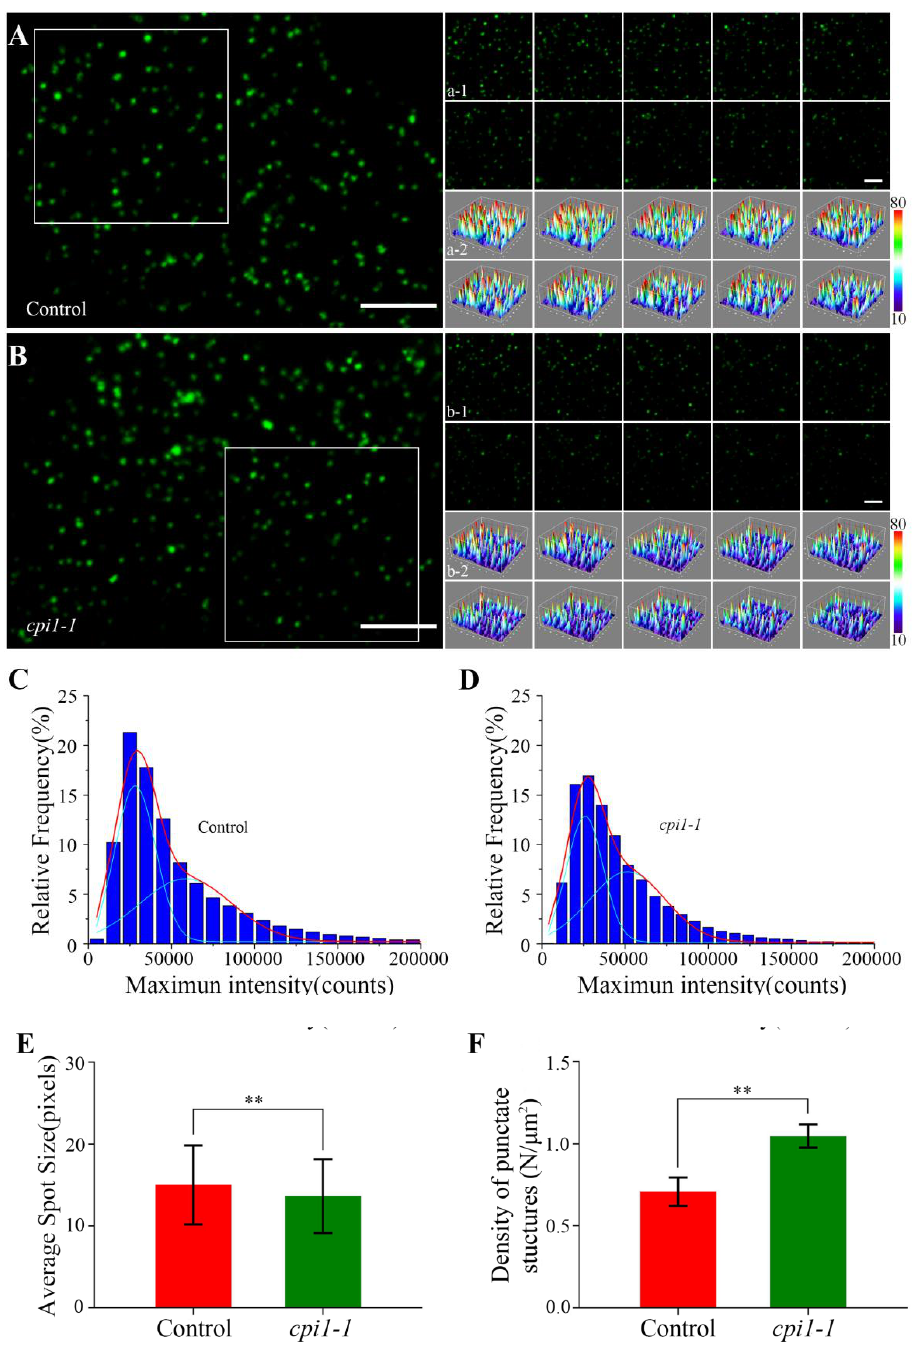
Figure 3. Fluorescence intensity on the membrane of Flot1-GFP expressing plants. ( A ) A typical single-particle image for Flot1-GFP at the plasma membrane in control seedlings. Scale bar, 2.5 µ m. (a-1) Dynamic analysis and (a-2) three-dimensional luminance plots using a time series of the boxed area in (A). Scale bar, 2.5 µ m. ( B ) A typical single-particle image for Flot1-GFP at the plasma membrane in cpi1-1 mutants. (b-1) Dynamic analysis and (b-2) three-dimensional luminance plots using a time series of the boxed area in (B). ( C,D ) Maximum intensity of Flot1-GFP in (C) control ( n = 5782 spots) and (D) cpi1-1 mutant seedlings ( n = 7196 spots). ( E ) Average spot size and ( F ) the density at the plasma membrane of Flot1-GFP fluorescent spots in cpi1-1 mutants ( n = 337 spots) and control seedlings ( n = 296 spots). Error bars represent the SD ( n = 4). ** p < 0.01, Student’s t -test.